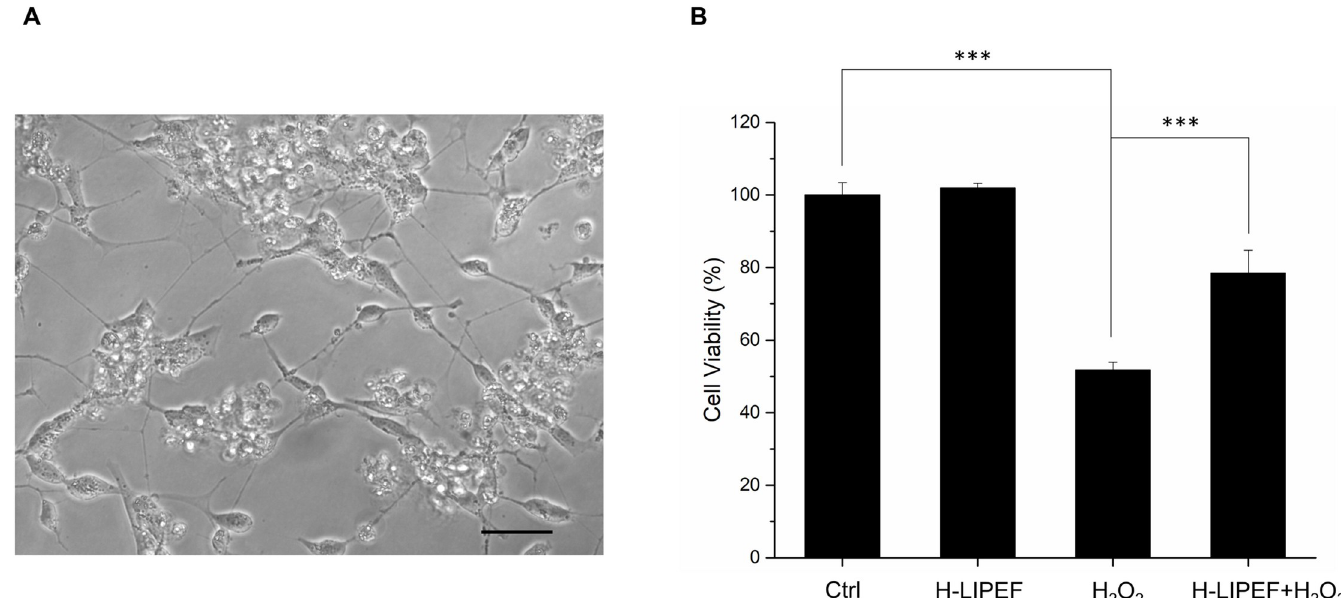
Fig 4. Effect of H-LIPEF on H 2 O 2 -induced cytotoxicity in differentiated SH-SY5Y cells. (A) Morphology of differentiated SH-SY5Y cells. Scale bar = 50 μ m. (B) Differentiated SH-SY5Y cells were pretreated using 200 Hz H-LIPEF with field intensity of 10 V/cm and challenged with or without 500 μ M H 2 O 2 for 24 h. The cell viability was then determined by MTT assay. Comparisons of the effect of H 2 O 2 and H-LIPEF on the cell viability were analyzed using two-way ANOVA with Tukey’s post hoc test ( ��� P <